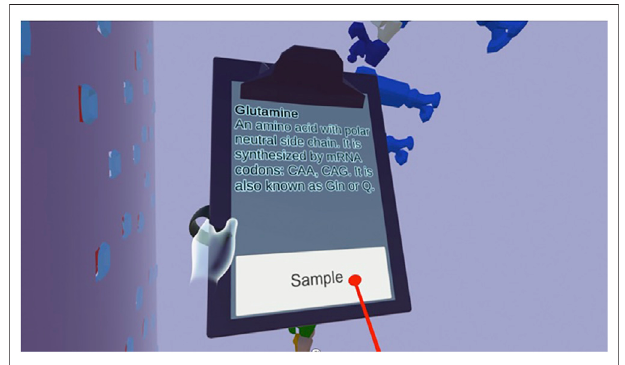
FIGURE 2 | Screenshot of clipboard tool showing a user sampling glutamine, an amino acid.